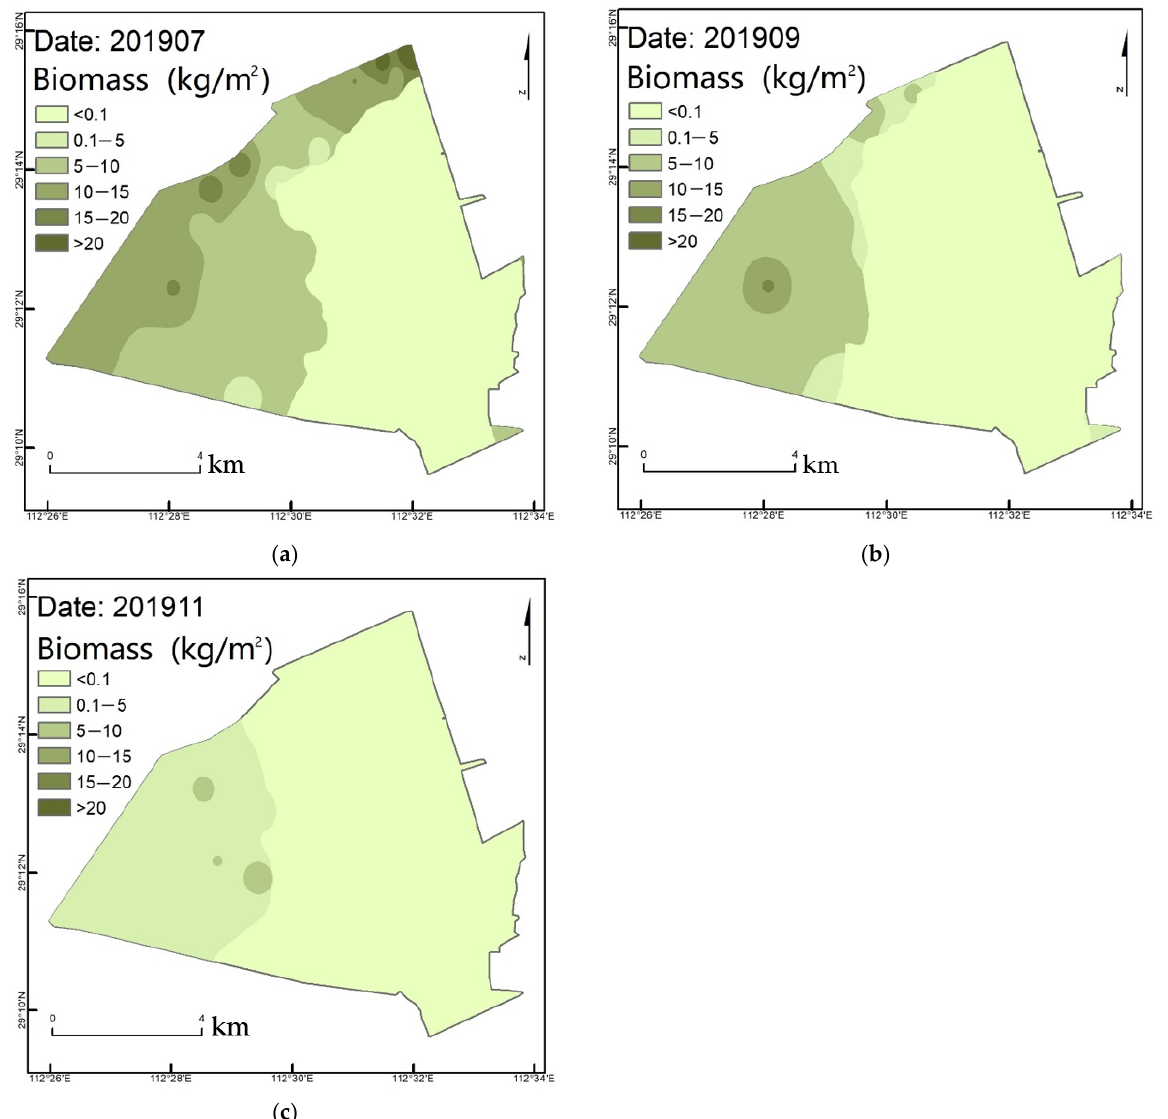
Figure 7. Biomass distribution of the macrophytes throughout Lake Datong.